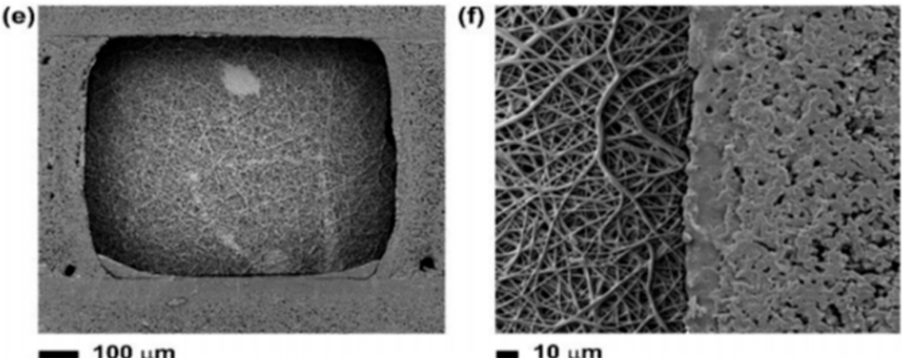
Figure 7. SEM images at different magnifications of ( a , b ) the 3D-printed scaffolds, showing also the BG microspheres exposed onto the surface or embedded into the polymer matrix (insets); ( c , d ) the surface of the composite scaffold covered with a layer of electrospun polycaprolactone (PCL)– poly (glycerol sebacate) (PGS) mats, pointing out the fusion between fibers; ( e , f ) the surface of the composite scaffold without the layer of electrospun fibers